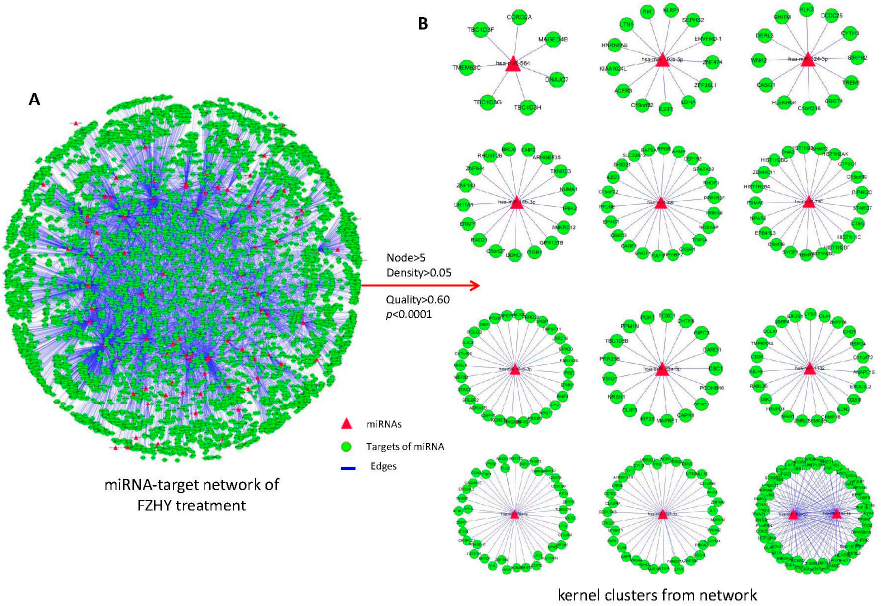
Figure 3. The miRNA-target network was constructed based on DE miRNAs and target genes, and the related clusters were identified using the ClusterONE algorithm. ( A ) The global profiles of the FZHY treatment-related miRNA-target network were built. The target genes of miRNAs were predicted using the TarBase (v7.0), miRecords and miRTarBase databases and the miRanda, miRDB, miRWalk and RNAhybrid prediction programs; ( B ) The kernel miRNA-related clusters isolated from the network using the ClusterONE algorithm, which was defined as node > 5, density > 0.05, quality > 0.60 and p < 0.0001. There are 12 clusters, containing 13 kernel miRNAs.